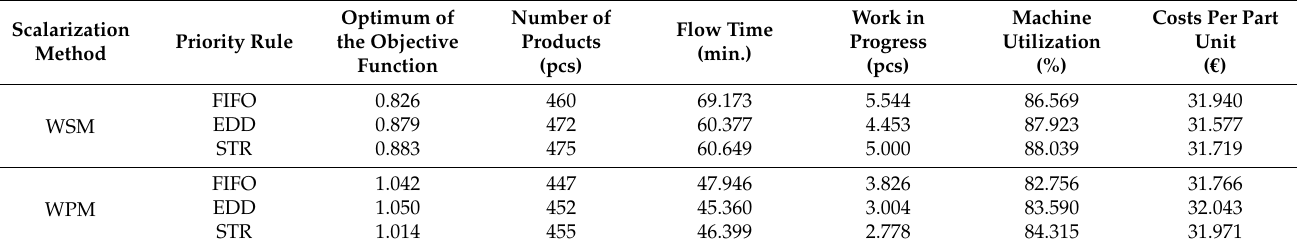
Table 7. Results of multi-criteria optimization based on scalarization for three priority rules.